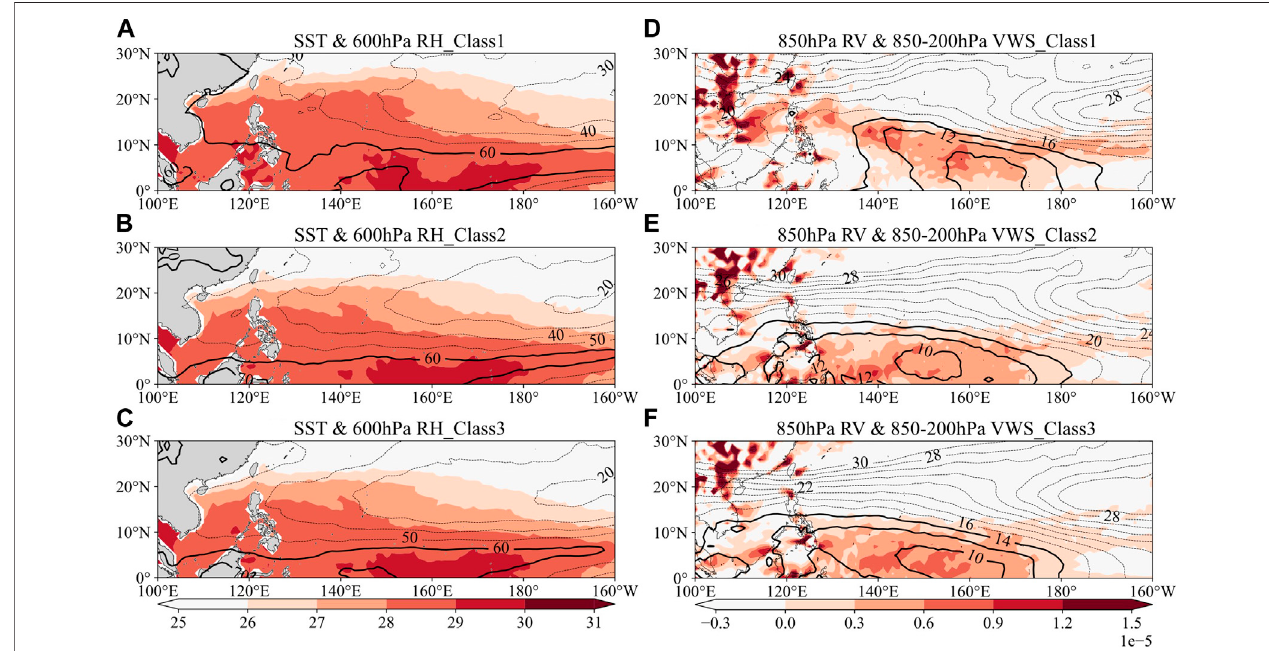
FIGURE 5 | Composite environmental fi eld of the three classes. (A – C) are the SST and 600 hPa RH. The solid thick lines refer to RH > = 60%, and the dashed thin linereferstoRH < 60%.ThecoloursrefertotheSST,andonlySST > 26 ° Cisplotted; (D – F) arethe850 hPaRVand850 – 200 hPaVWS.ThesolidthicklinesrefertoVWS < = 14, and the dashed thin line refers to VWS > 14. The colours refer to RV, and only positive RV is plotted.